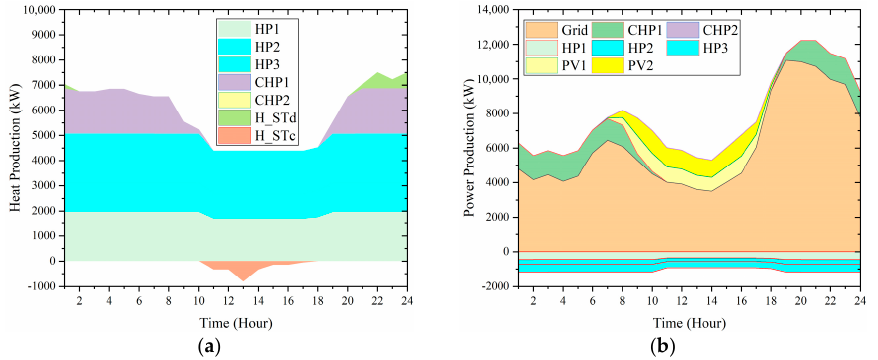
Figure 9. Operation results of heat pumps in heat output.